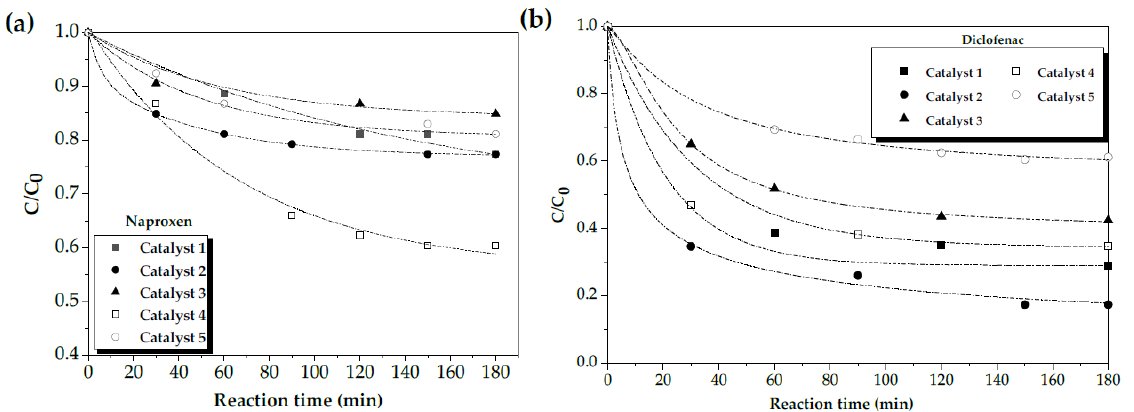
Figure 3. Evolution of ( a ) NAP and ( b ) DCF degradation by CWPO. As expected, the highest removal of DCF (66%) and NAP (40%) from aqueous solu- tion was obtained by using catalyst 4 by CWPO. That high removal could be related to the